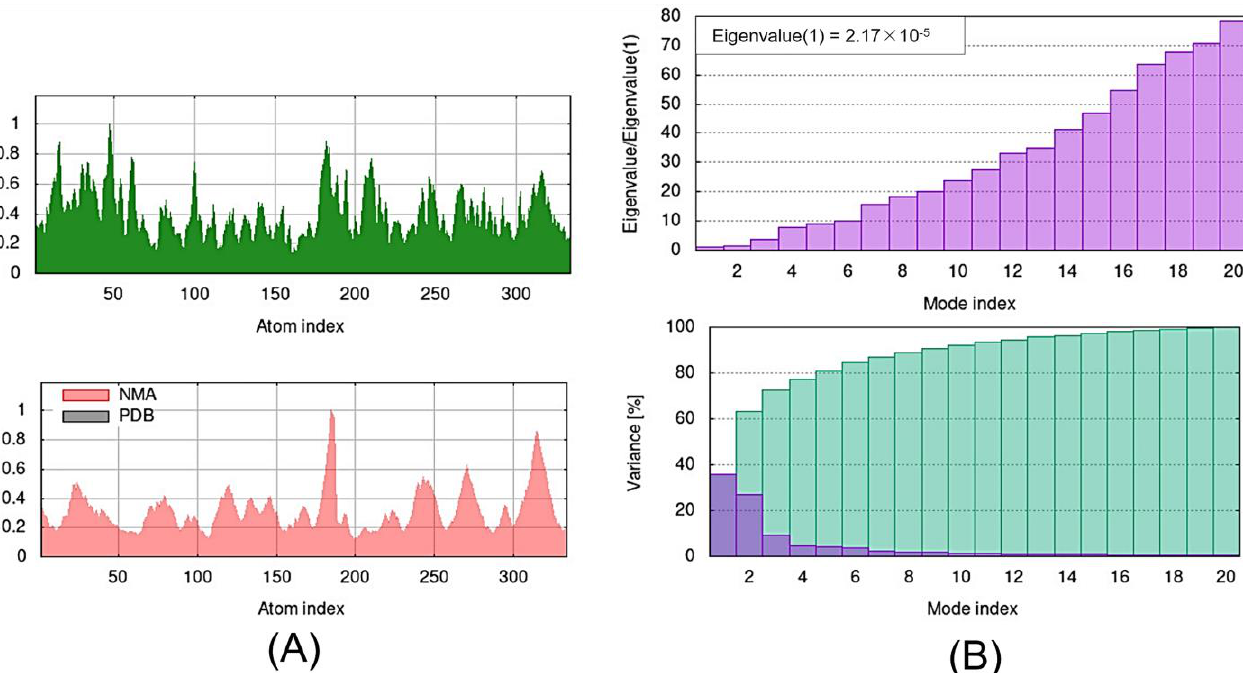
Figure 7. Outputs of molecular dynamics simulations through iMODS for GDF1-TMZ: ( A ) deform- ability and B-factor plot; ( B ) eigenvalue and variance plot; ( C ) elastic network model; and ( D ) co- variance map. 3. Discussion Molecular docking is a powerful in silico structure-based method that enables the prediction of ligand – target interactions at a molecular level. The present study highlights the potential of TMZ to interact with the secretory proteins involved in the pathological processes of GBM through molecular docking and interaction studies. To probe for alter- nate diagnostic, tumor-monitoring and less invasive strategies, as well as identify novel target molecules of TMZ, we chose these nine proteins based on the available literature about their function and potential association with tumors. Among the nine proteins, SLIT1 showed the highest binding affinity with TMZ. Alt- hough SLIT1 displayed no hydrogen bonds with TMZ, it nonetheless presented other in- teractions with TMZ that play a vital role in increasing the overall binding energy. The peptide conformation of SLIT1 revealed the maximum binding of TMZ with residues